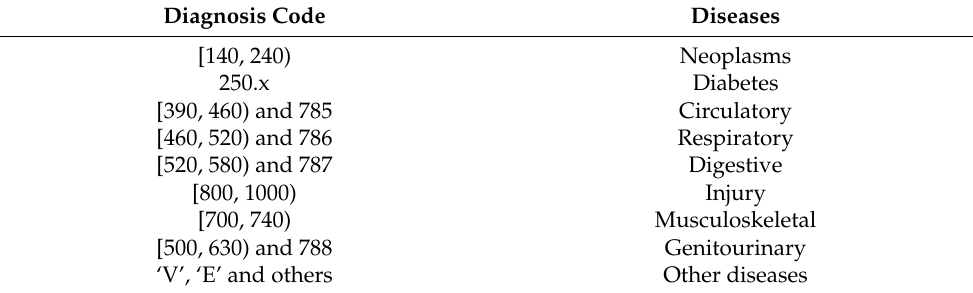
Table 1. ICD-9-CM